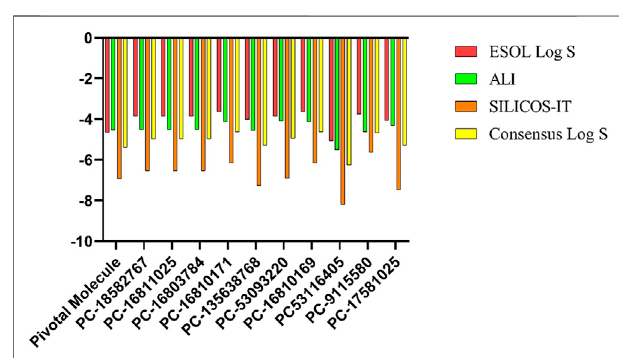
FIGURE 11 | logP values predicted using different methodologies for pivotal molecule and 10 promising compounds. Pivotal molecule: Roc-A; PC: PubChem.